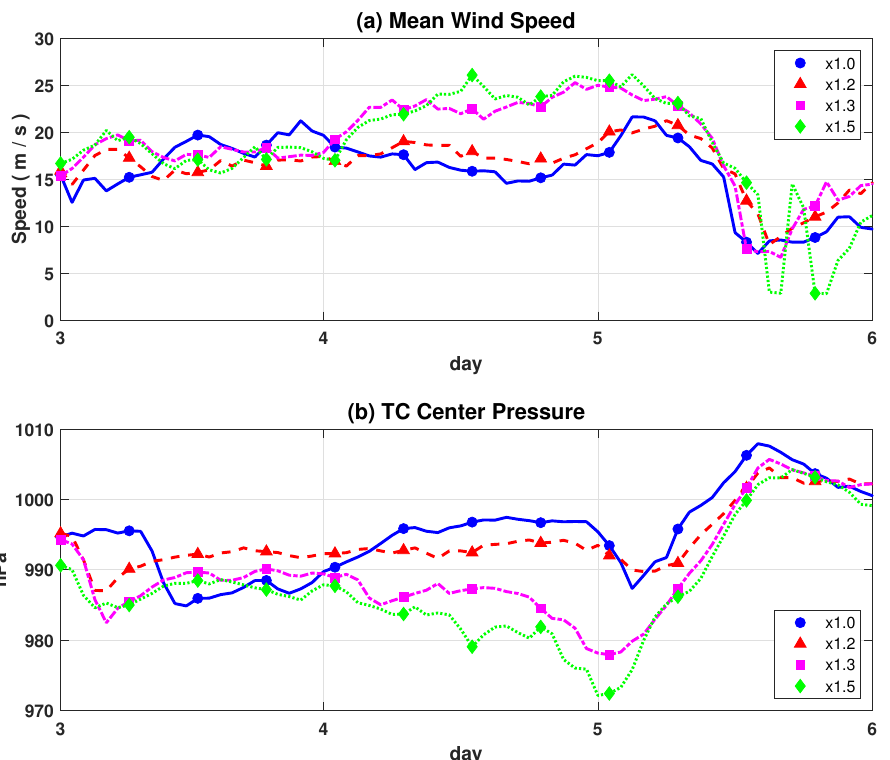
Figure 9. The wind speed averaged within 3 degrees from the TC center ( a ) and central pressure ( b ) during 3–6